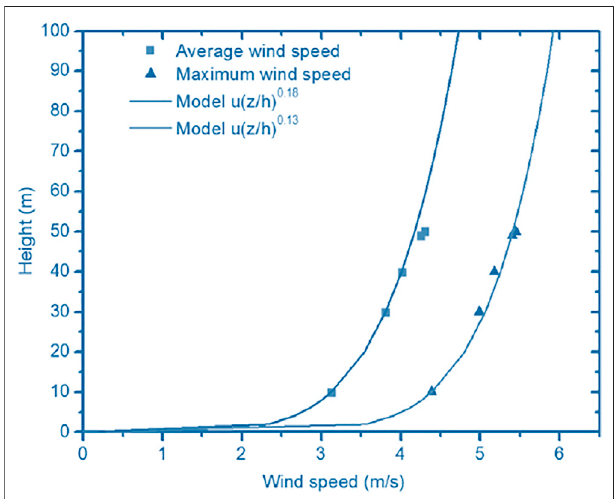
FIGURE6| RelationbetweenWindsystemandheight(LiuandJanajreh,